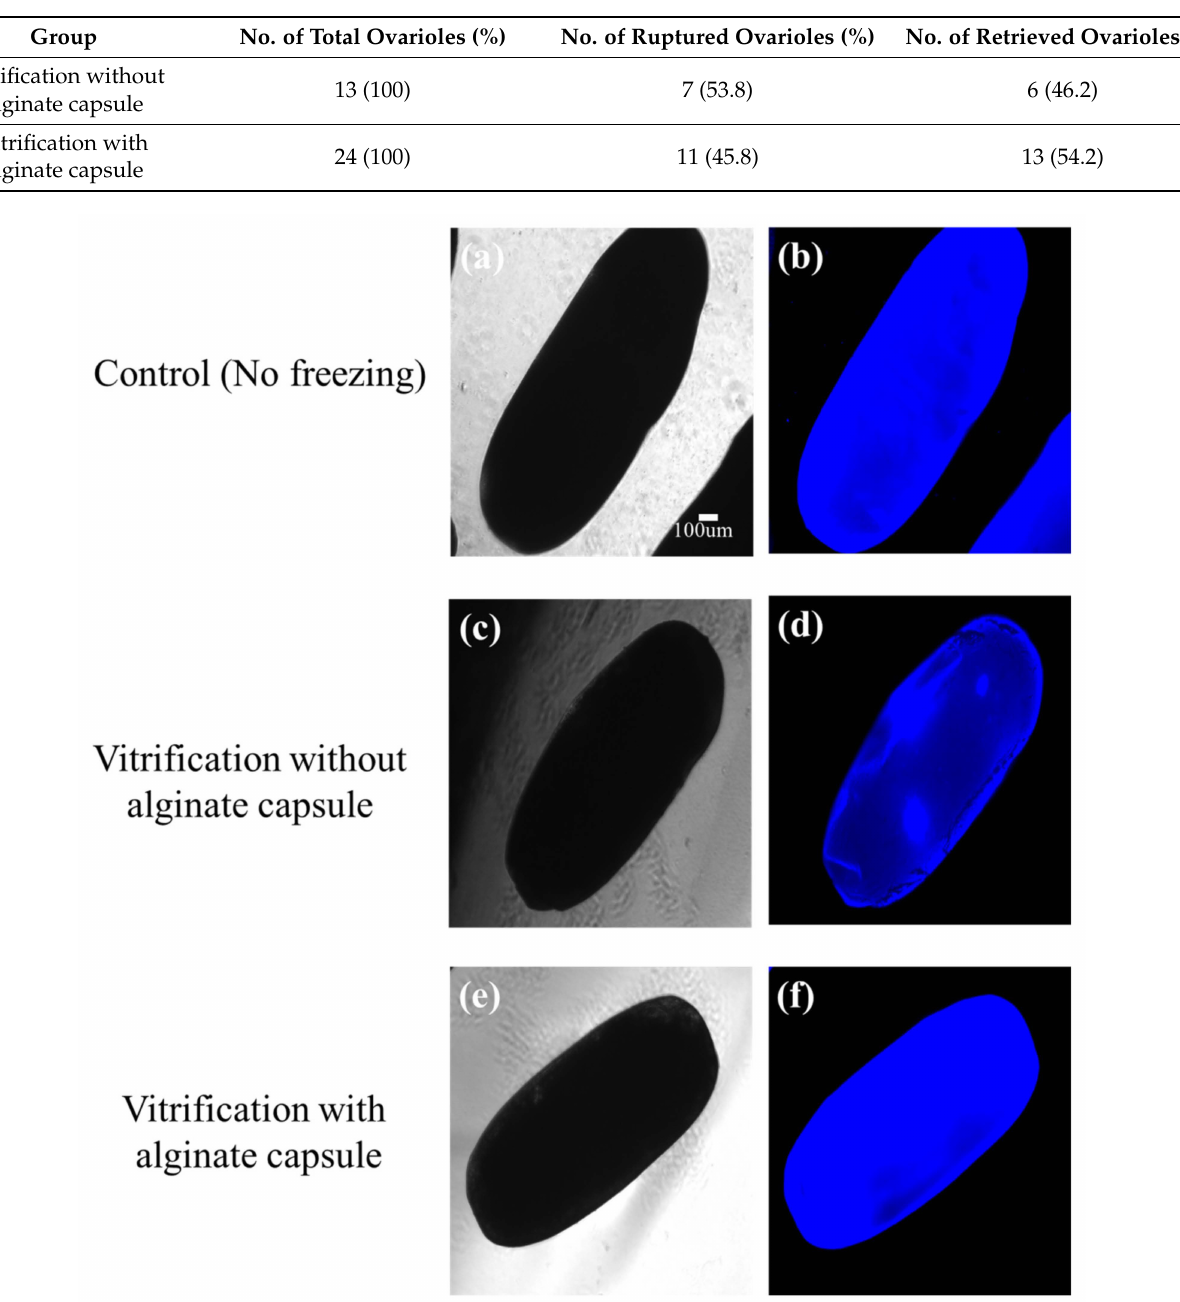
Figure 9. Viability of female adult mealworms by vitrification of the ovariole with or without an alginate-capsule. Alginate-encapsulated ovarioles were stained evenly, similarly to the control ( a , b ); the ovarioles without an alginate capsule (WOAC) had DAPI staining in a specific area ( c , d ); alginate- encapsulated ovarioles were ruptured less than the ovarioles WOAC ( e , f ). Scale bars = 50 µ